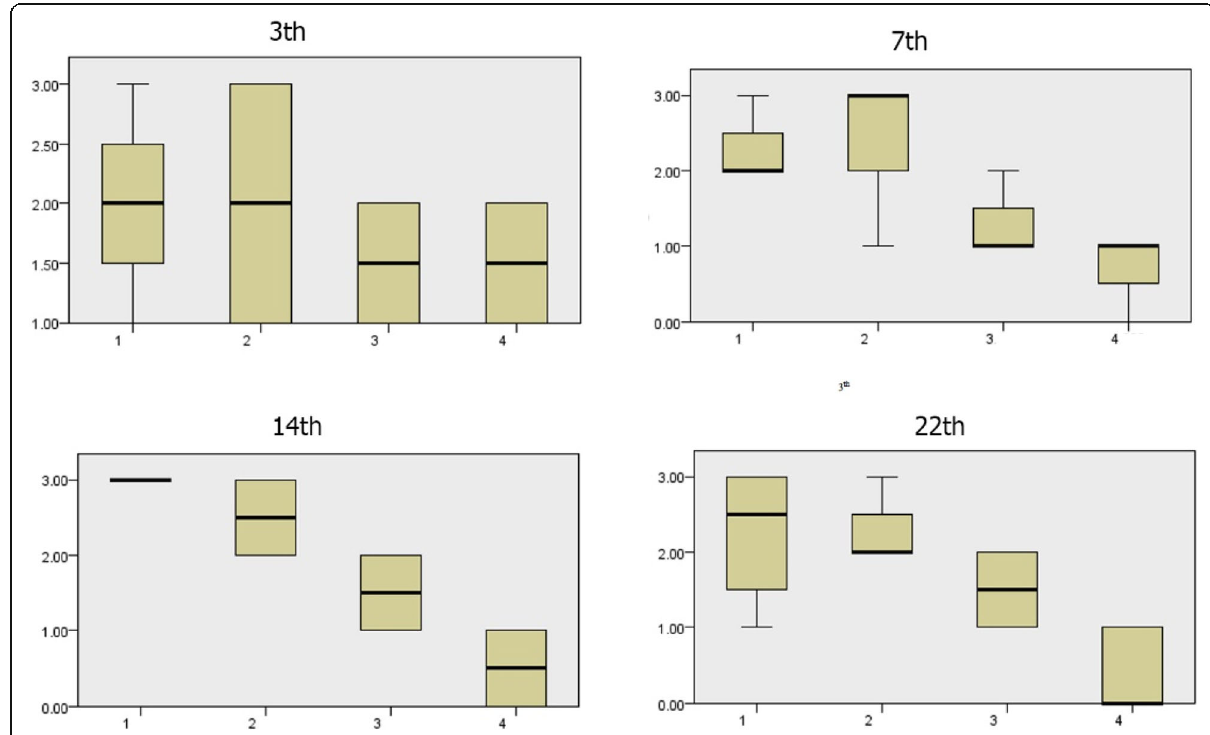
Fig. 2 Wound blood vessels scores during the 3rd, 7th, 14th, and 22nd days. There is a significant difference in the amount of wound blood vessel formation. In the treated groups, the amount of wound blood vessels formation was less than the control group, and less blood vessel formation causes more improvement to lead to effects in the healing process more than the control group. (1) Control group, (2) Satureja khuzistanica -treated group, (3) alginate hydrogel dressing-treated group, and (4) alginate hydrogel/ Satureja khuzistanica dressing-treated